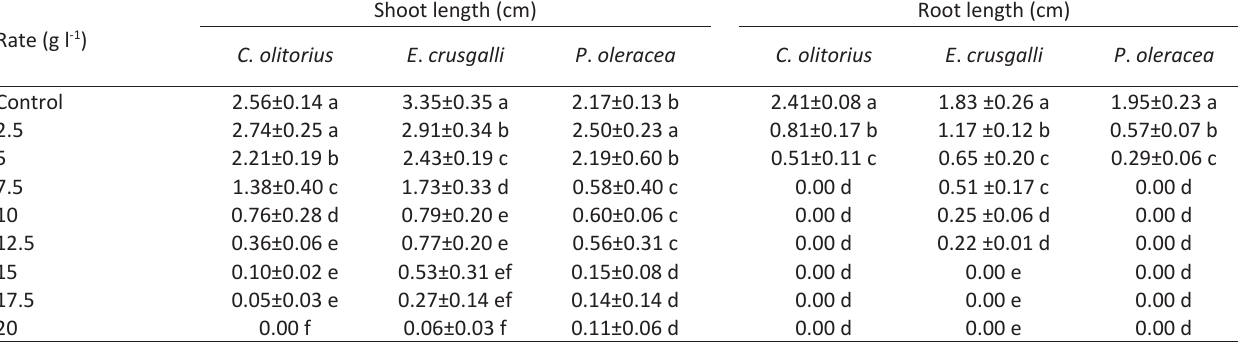
Values are given as means of three replicates ± standard error. Means with the same letters in a column are not significantly different